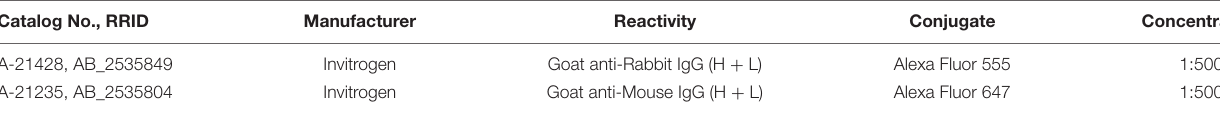
TABLE 2 | Secondary antibodies used in